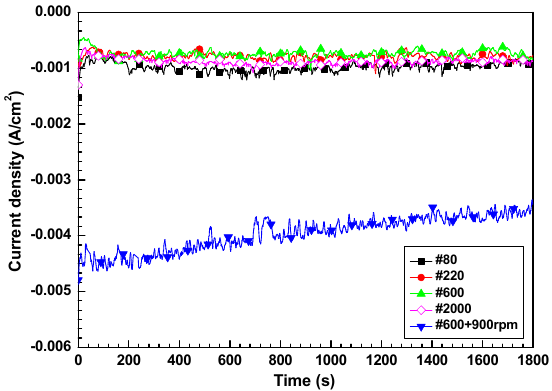
Figure 4. Current density variation with different roughnesses and agitation speeds during electrodeposition at − 1.05 V SCE in Fe(III)–TEA solution at 80 °C.